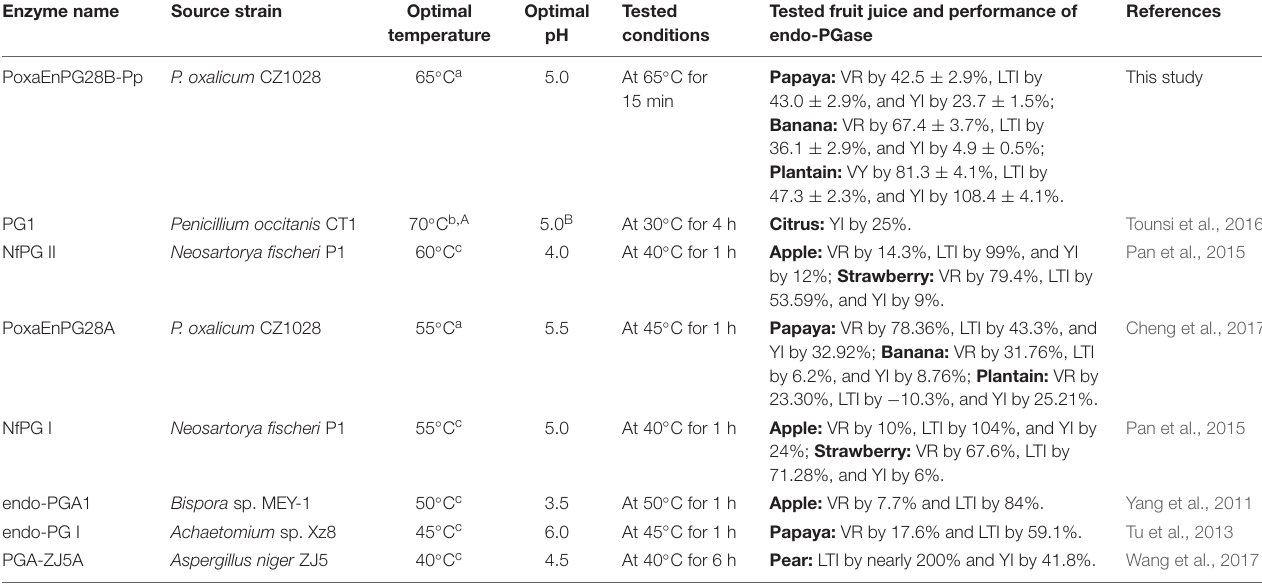
TABLE 3 | Comparison of enzyme characteristics and performance in fruit juice production of reported